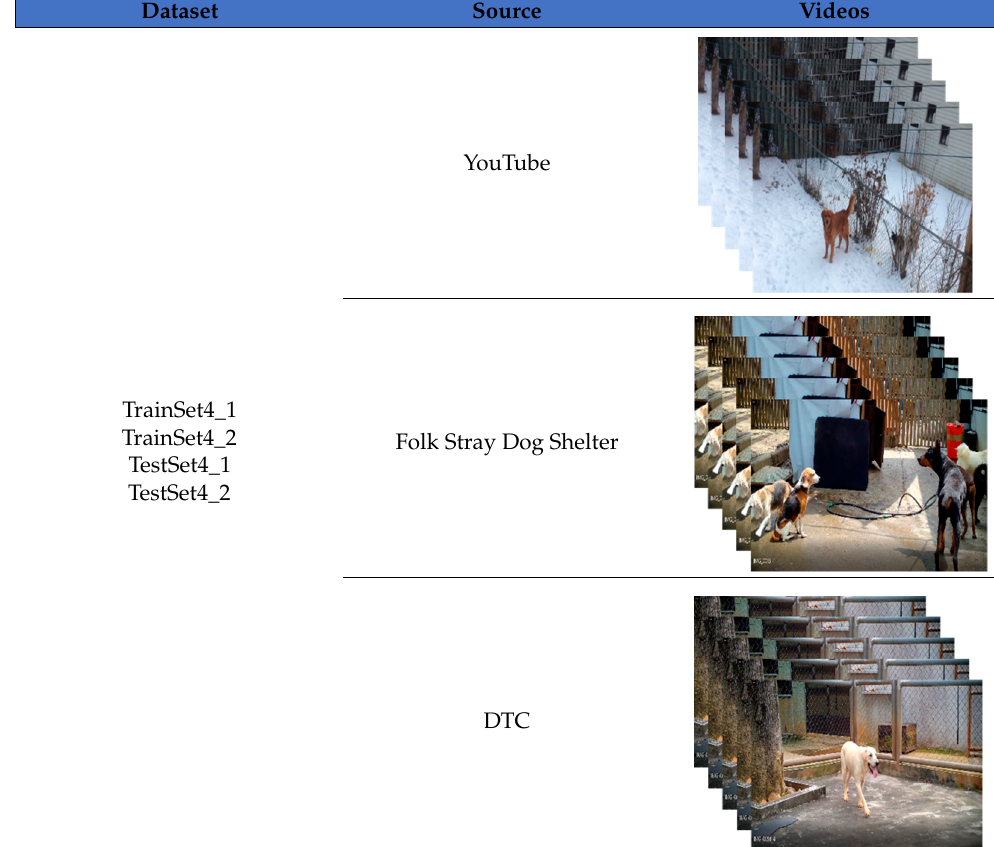
Table 6. The data-set for dog emotion recognition model.